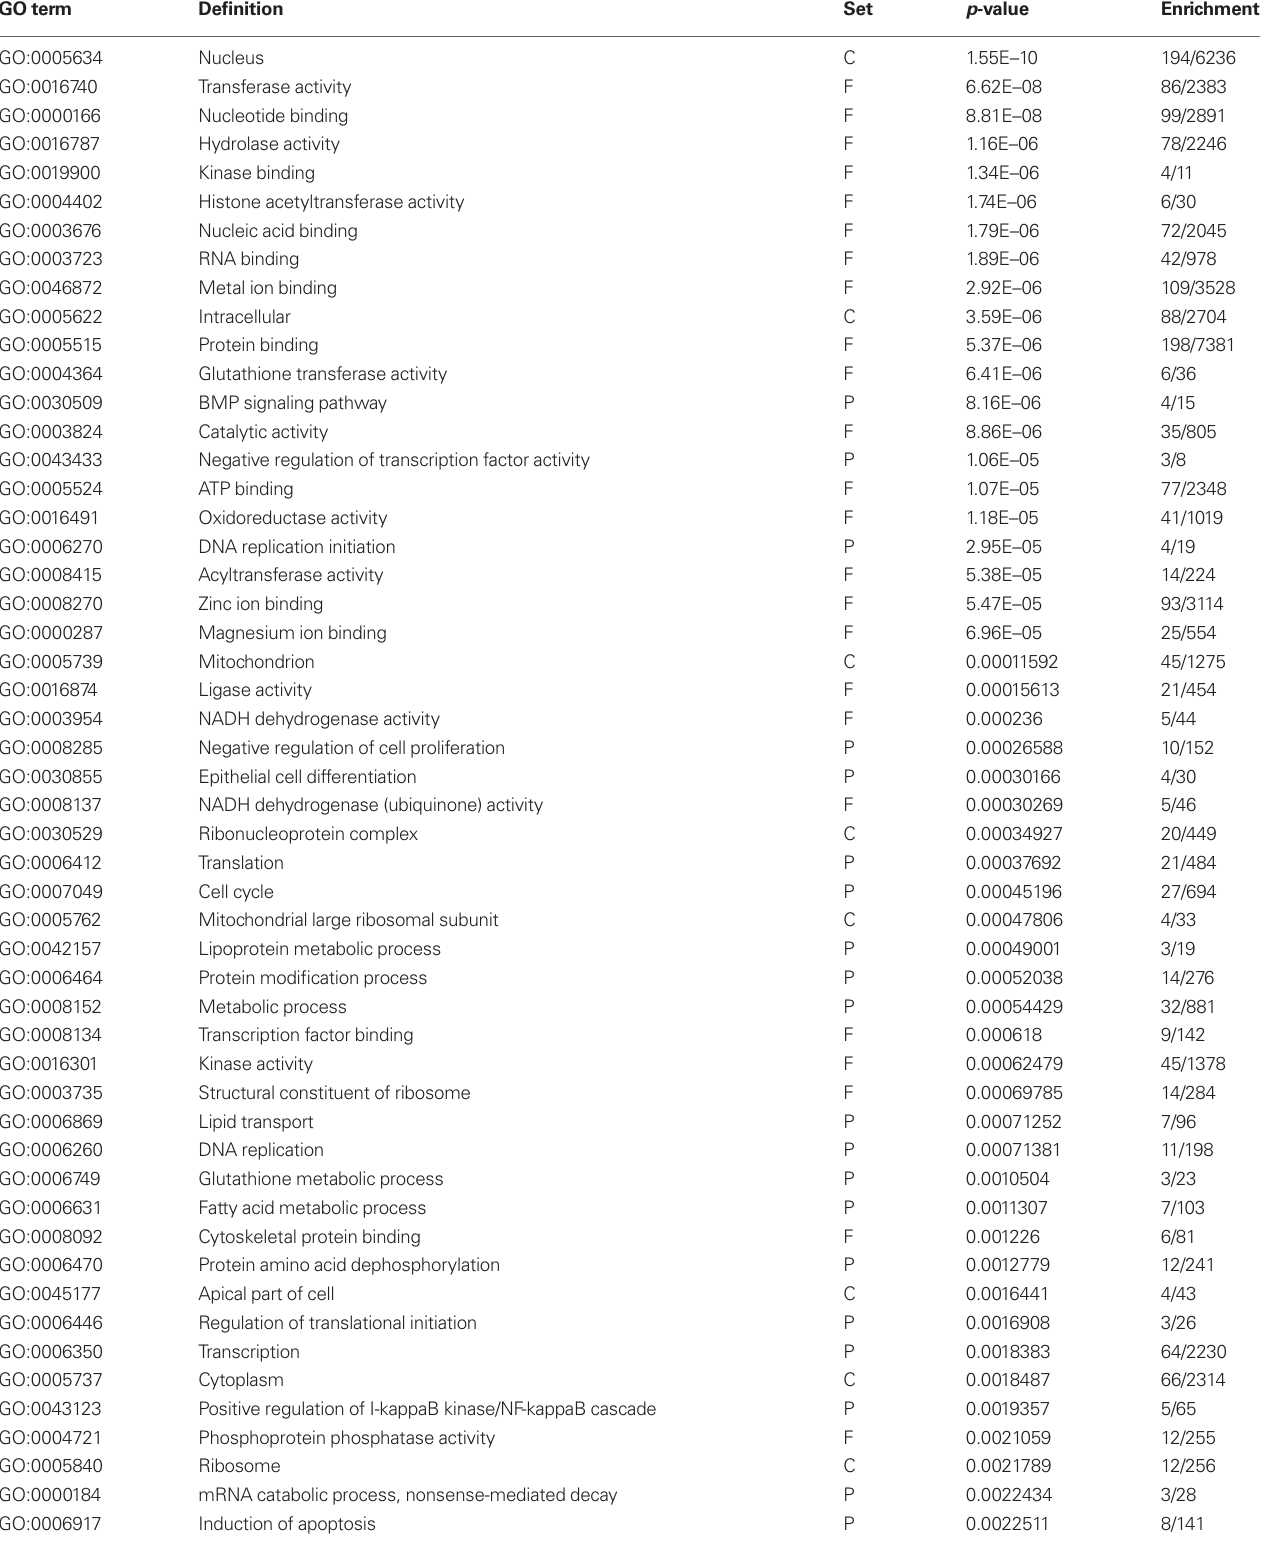
Table 1 | A list of significantly enriched GO terms derived from the data in (Moulos et al . , 2009) after the application of